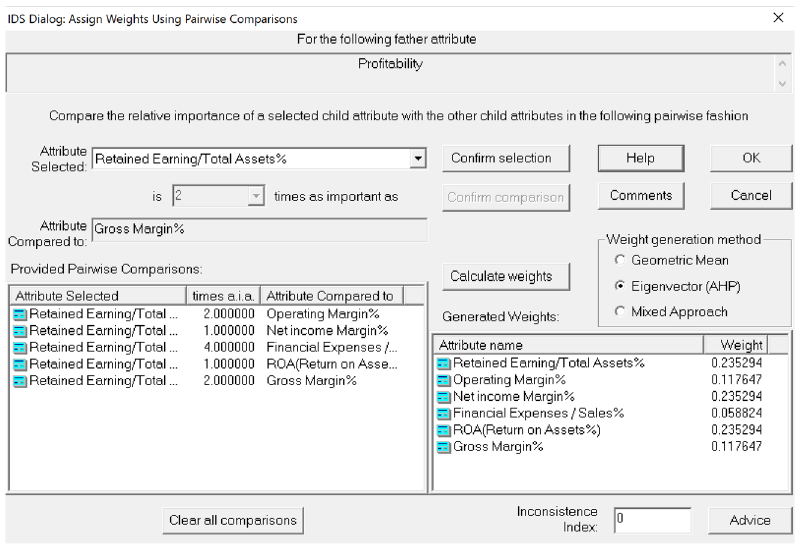
Figure 4. Assigning weights to attributes.